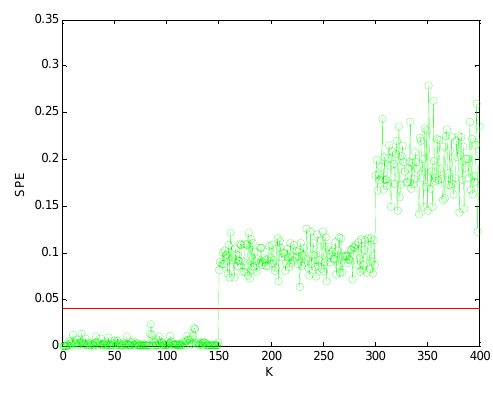
Figure 8. SPE value with sensors 2, 3 reconstructed.